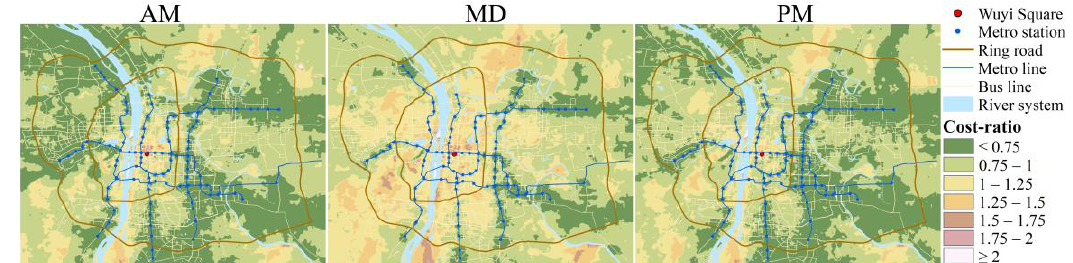
Figure 6. Cost-ratio distribution for the three time periods.